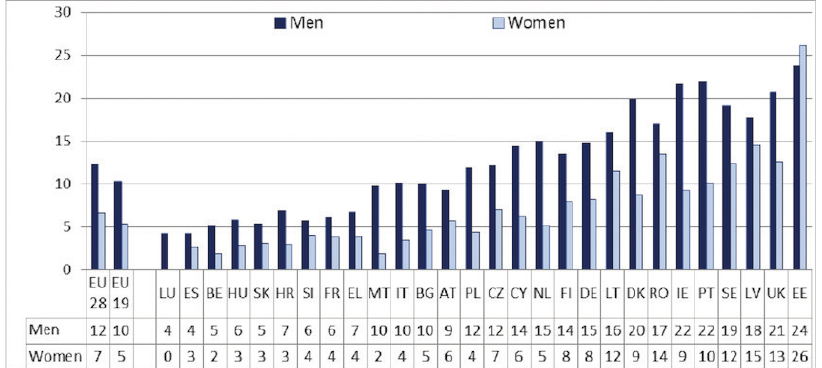
Figure 2. Employment rate of older people in different EU countries